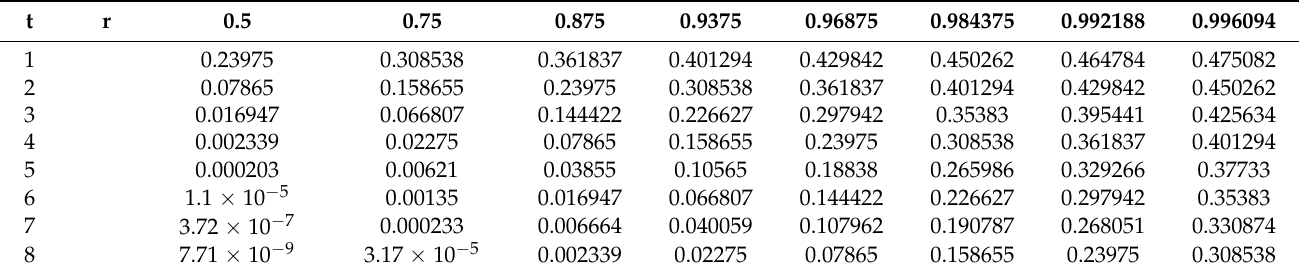
Table 1. The probability that a SNP in LD with the CV is more significant than the CV. (t = true t-value for the CV, r = LD correlation between CV and